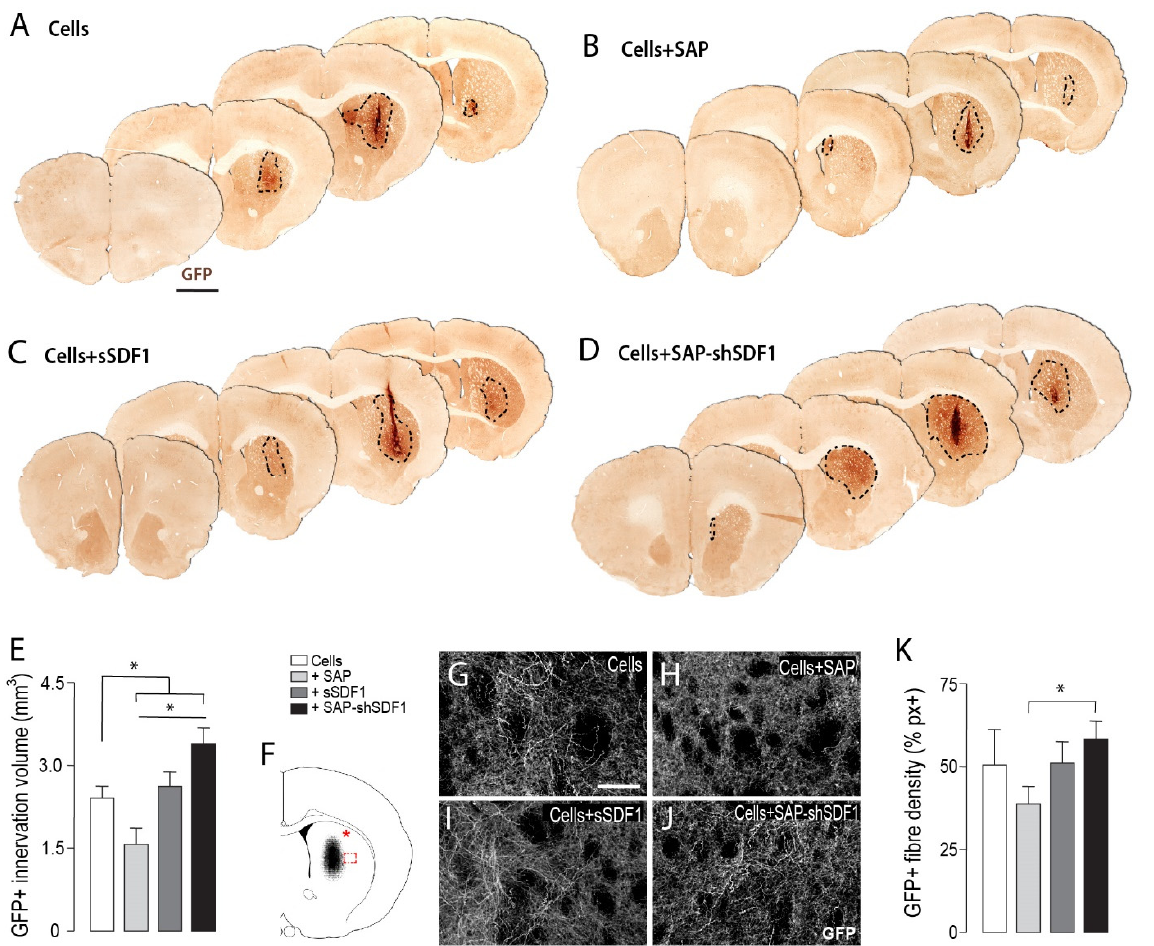
Figure 3. Laminin-based SAP hydrogels, functionalised with SDF1, enhance graft innervation volume and fibre density. ( A – D ) Representative photomicrographs of VM foetal tissue grafts in the presence of SAP and/or SDF1, depicting increased GFP+ DA innervation from grafts exposed to SDF1-functionalised scaffolds. Dashed line delineates the GFP+ graft-derived innervation volume. ( E ) Quantification of volumetric GFP+ fibre innervation of the host striatum. ( F ) Schematic illustrating sampling site for assessment of GFP fibre density within the dorsolateral striatum (*) and at the graft-host boundary (boxed area). ( G – J ) Representative photomicrographs showing GFP fibre density at the graft host border. ( K ) Quantification of graft-derived GFP fibre density at the graft–host boundary. Data represent Mean ± SEM, n = 5–7 Grafts/group. * p < 0.05. Scale bars: ( A – D ) 2 mm, ( G – J ) 200 μ m.